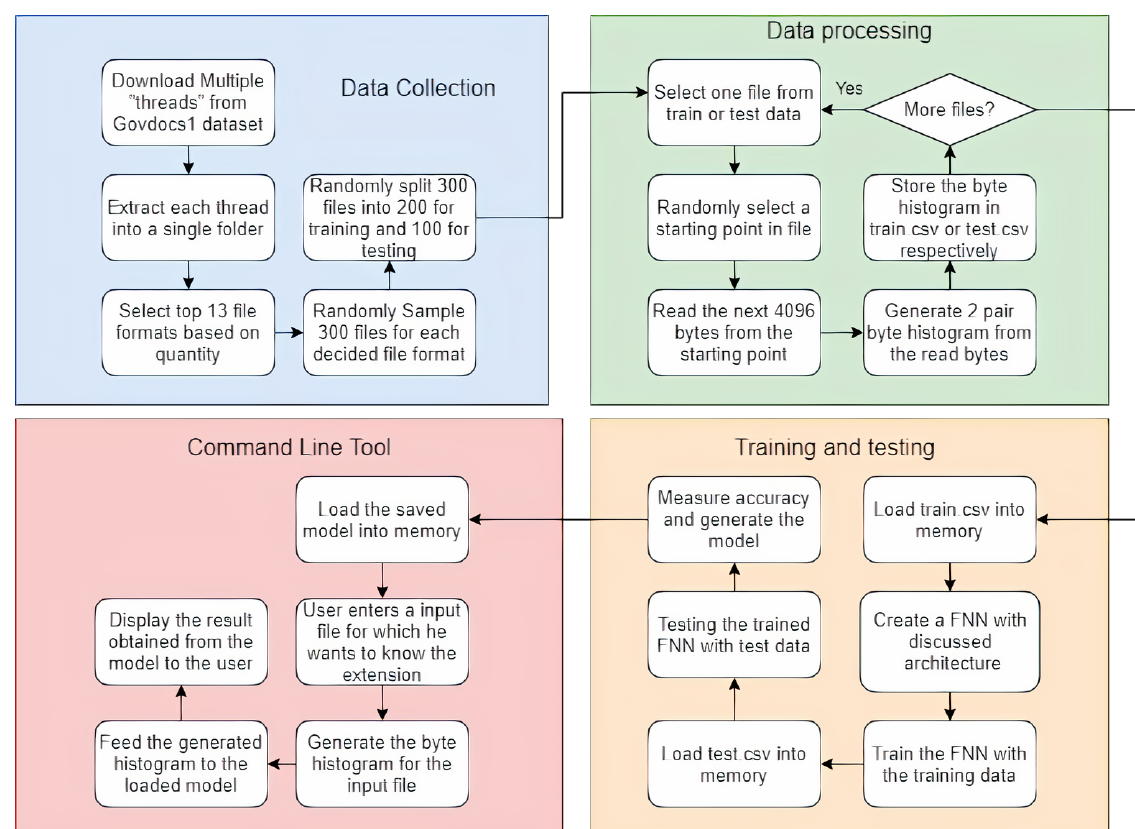
Figure 2. System Design which shows the workflow of the entire system